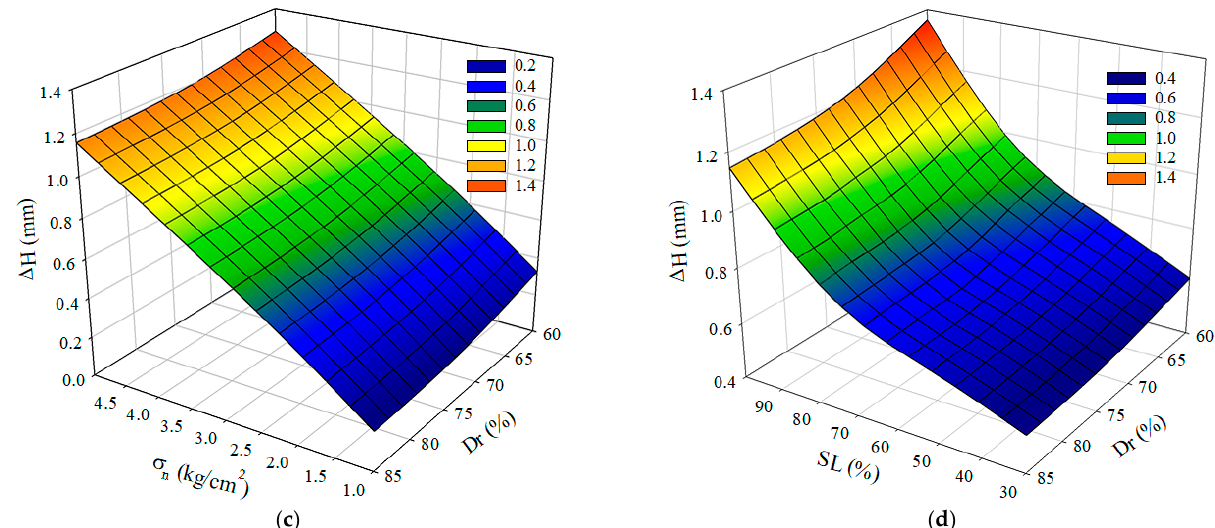
Figure 16. Effect of input parameters on collapse settlement. ( a ) interactive effect of σ n and SL, ( b ) interactive effect of Dr and SC, ( c ) interactive effect of σ n and Dr, ( d ) interactive effect of SL and Dr.